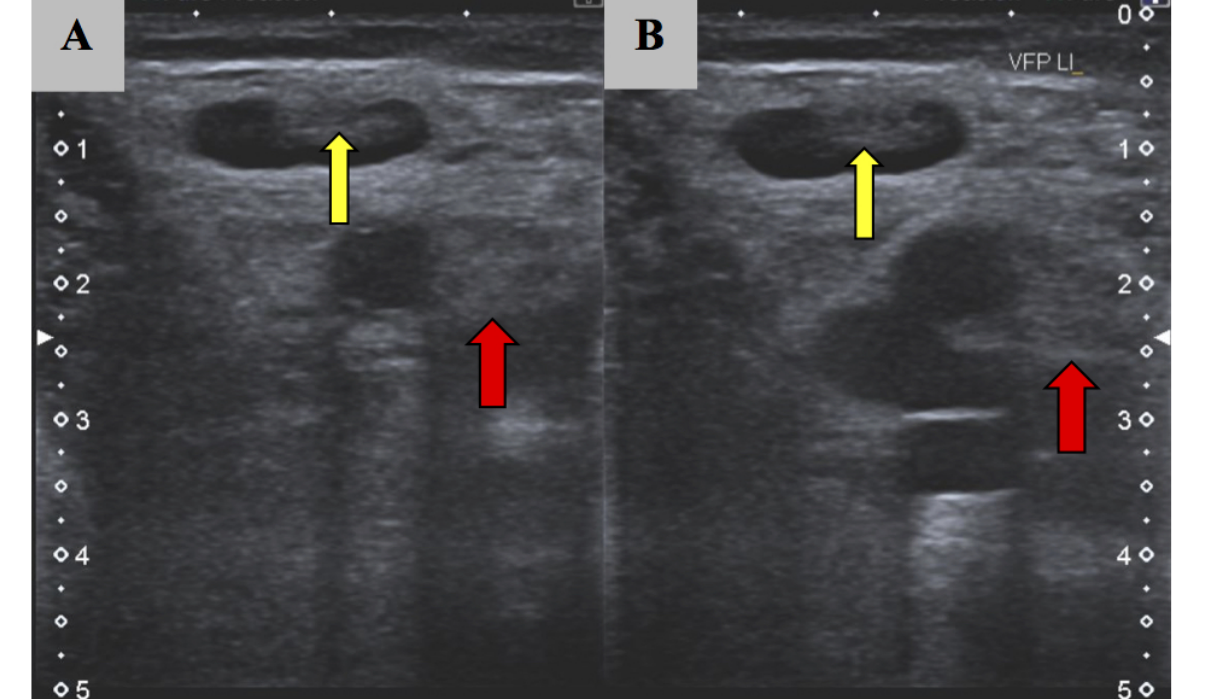
Figure 1. Ultrasound of the left lower extremity showing noncompression of the left saphenous vein (red arrows) and left posterior tibial vein (yellow arrows), as well as a visible thrombus in the lumen. Panel A and Panel B show a well-formed Thrombus in two different